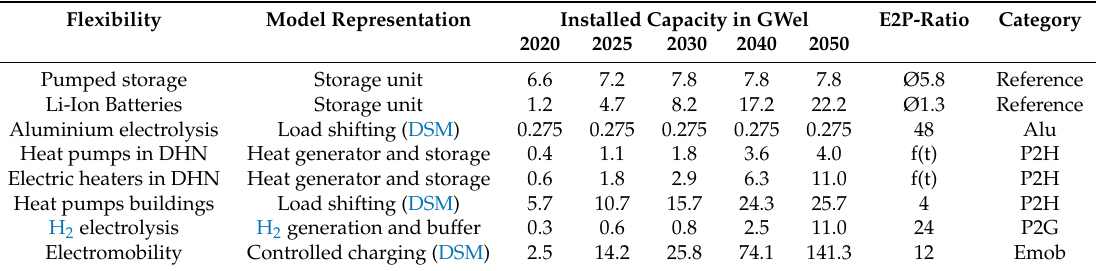
Table 2. Overview of flexibility options considered and main characteristics.